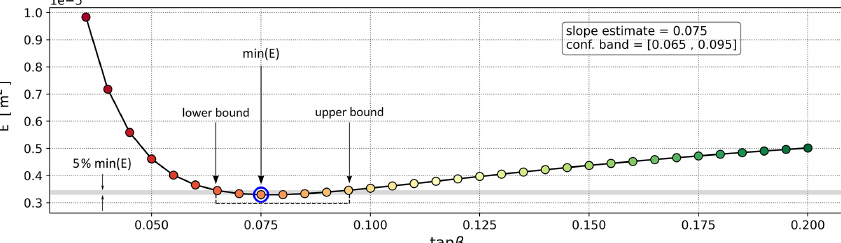
Figure 3. Estimation of the confidence band around each beach-face slope estimate based on the tidal energy vs slope curve. The lower and upper bounds are the slopes that are associated with a tidal energy within 5% of the minimum.